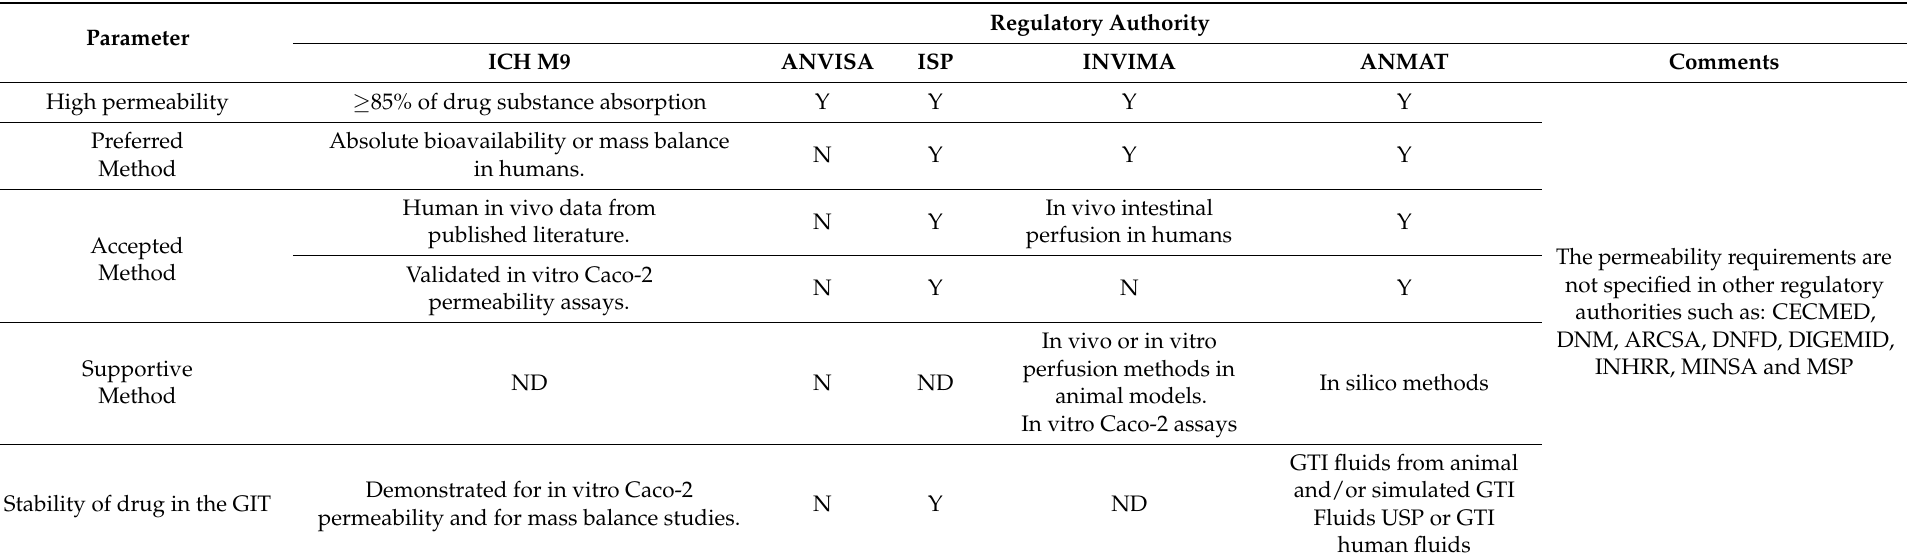
Table 3. Comparison of permeability requirements for BCS-based biowaivers between ICH and Latin American regulatory